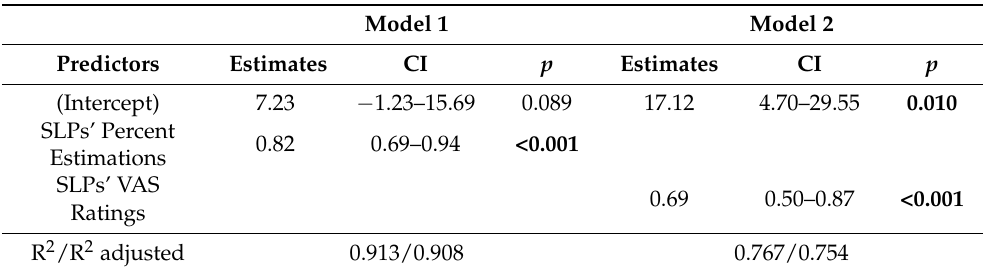
Table 3. Models Predicting Naïve Listeners’ Orthographic Transcription using SLPs’ Percent Estima- tions and SLPs’ VAS